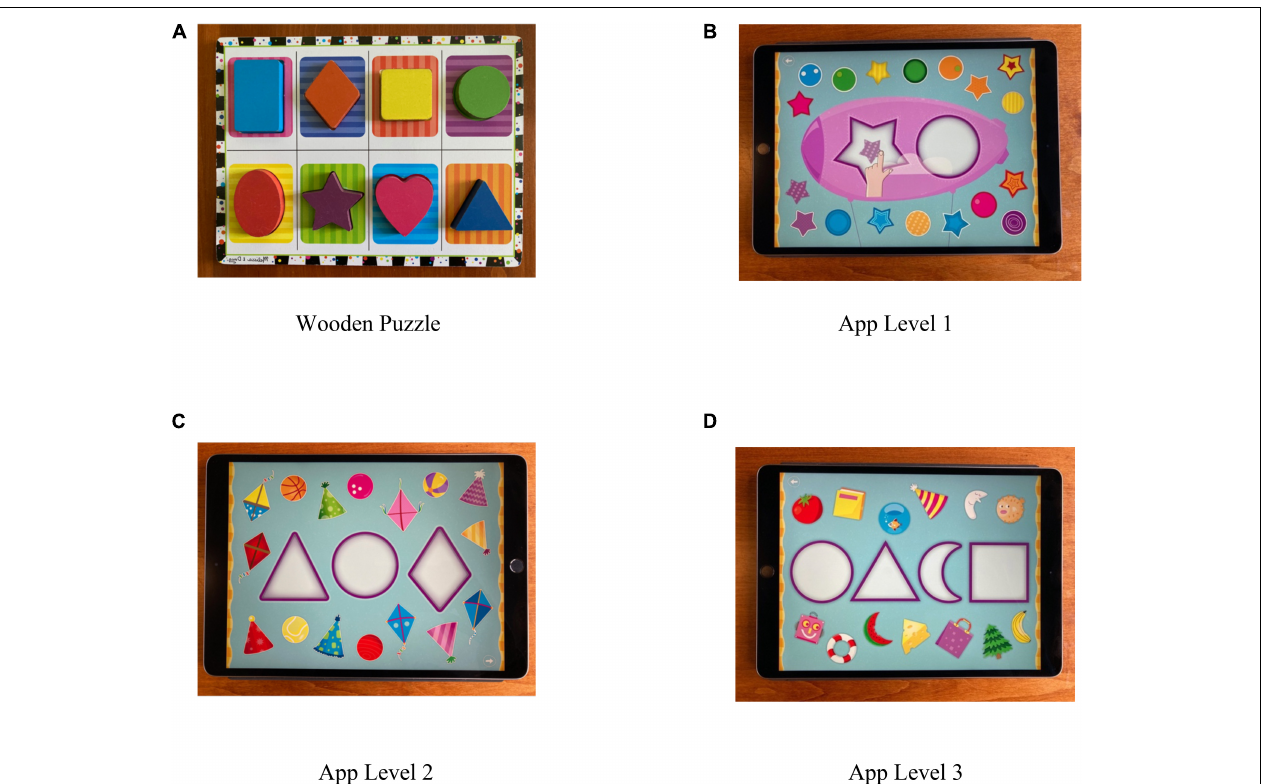
FIGURE 1 | Wooden (A) and electronic (B–D) shape matching puzzles. The wood puzzle is from the Melissa and Doug Toy Company , Wilton, CT, United States. The electronic puzzles are apps from TinyHands,